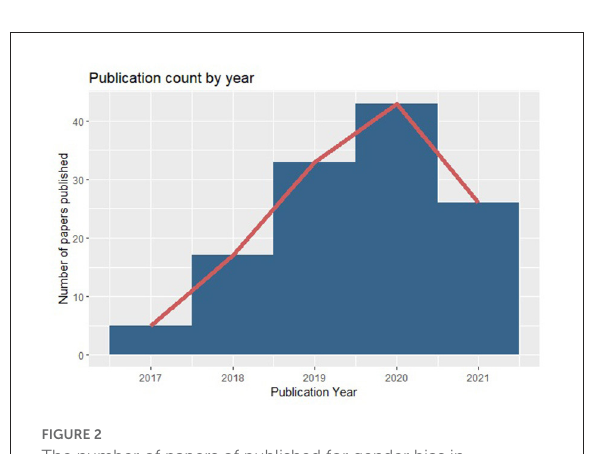
FIGURE2 The number of papers of published for gender bias in automated systems based on publication